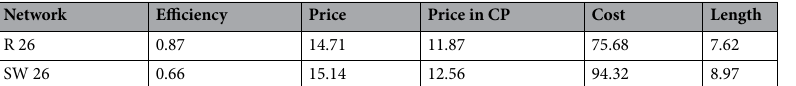
Table 2. Numerical results in experimental networks. Efficiency (fraction of rounds in which the cheapest path cost was equal to or less than the threshold), and mean values of the price, price in the cheapest path, cost of the cheapest path, and cheapest path length. Results obtained from numerical simulations with each one of the two studied networks with their corresponding source and destinations.